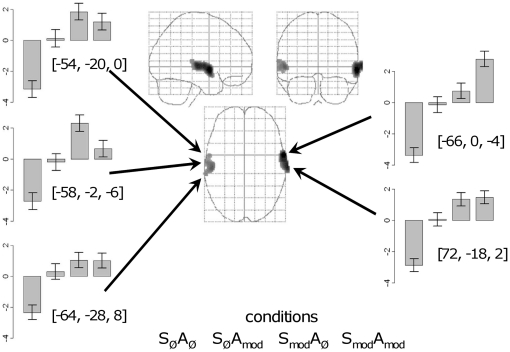
Neural activation revealed by the additive effects contrast SmodAmod>(SmodAØ and SØAmod)>SØAØ.The activity, projected onto a “glass” brain, is thresholded at p<0.0001 with a cluster threshold of 40. The five activation plots show the mean effect sizes (centred on zero) with the error bars showing the standard error of the mean. The order of the conditions plotted is shown at the bottom of the figure.